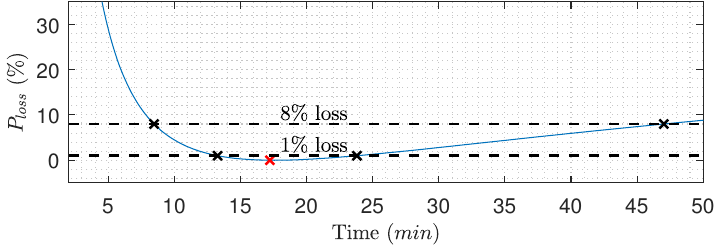
Figure 13. Average flux loss as a function of time (Equation (17)), where the red cross is the optimal point (0% P loss )—based on data from Figure 11.